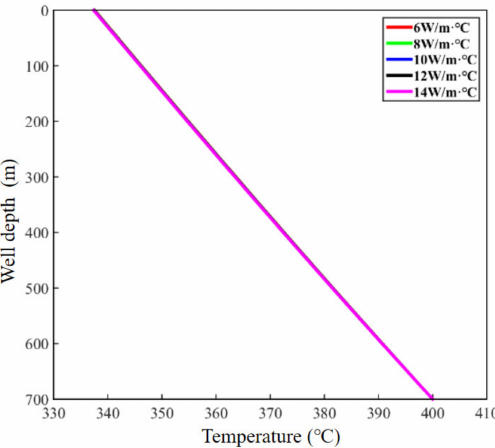
Figure 17. Temperature distribution of spray water using different total heat transfer coefficients of cement sheath casing.